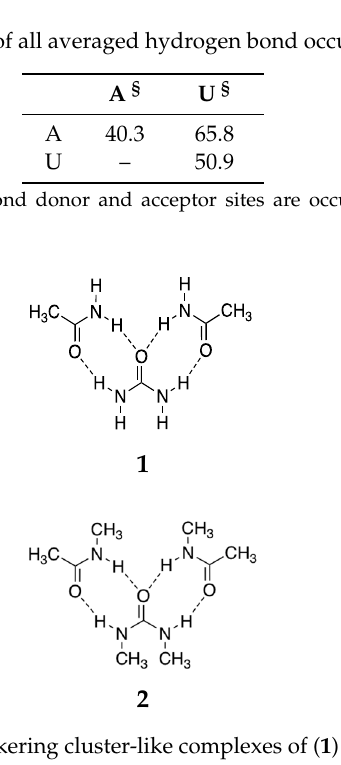
Figure 1. Structure of suggested flickering cluster-like complexes of ( 1 ) A–U and ( 2 ) NMA–NN’DMU.